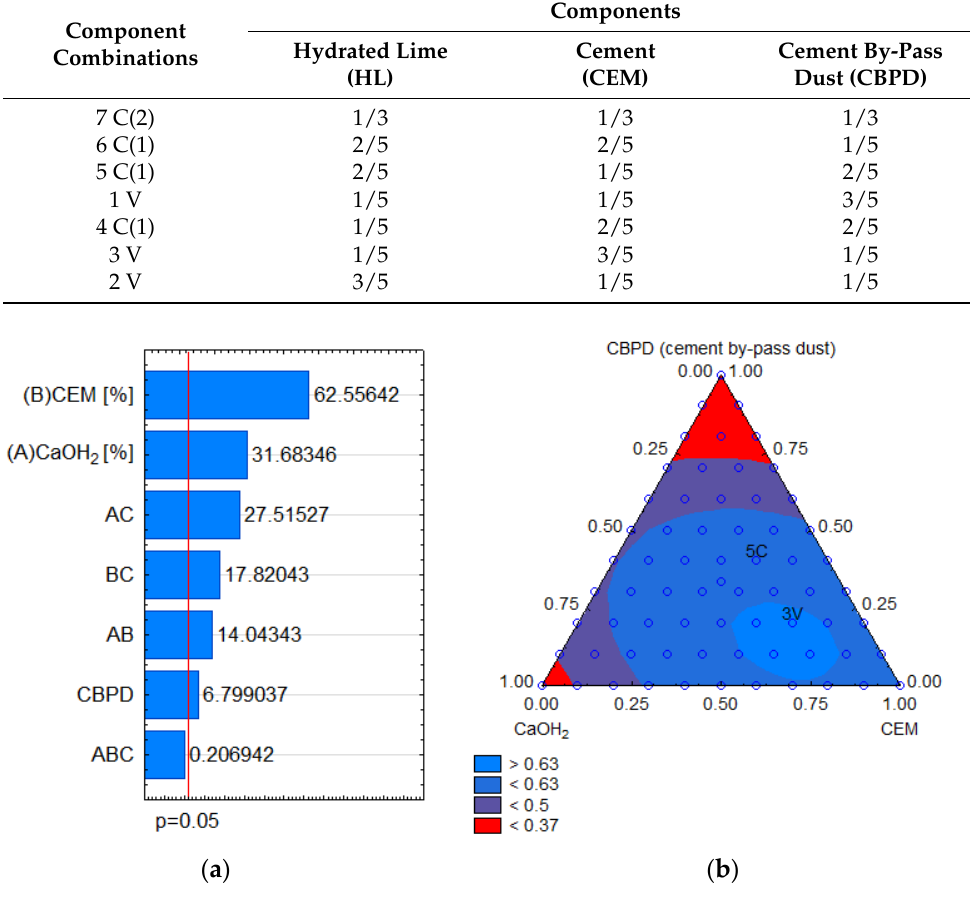
Figure 1. Three-component road binder optimisation result: ( a ) Pareto chart; ( b ) desirability function result of binder quality.